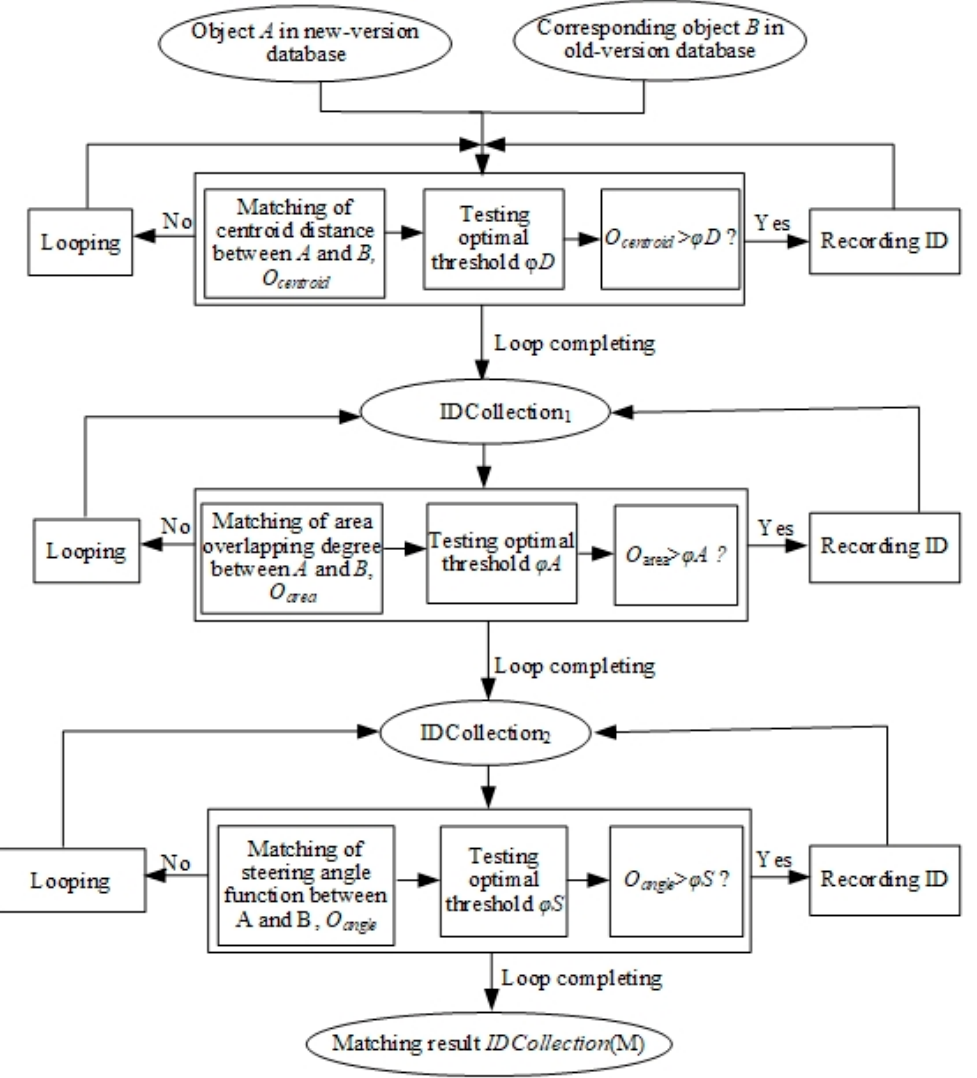
Figure 2. Illustration of extracting the change information based on hierarchical feature matching.